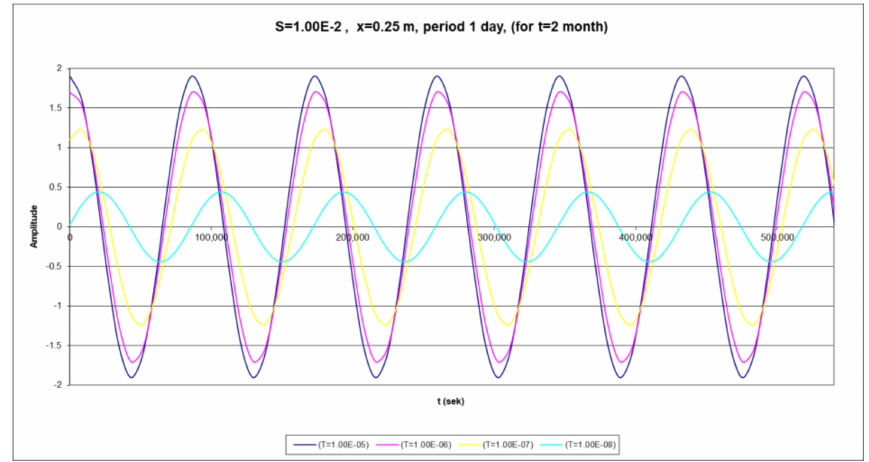
Figure 11. Influence of reservoir bed clogging for different values of T , computed by Equation